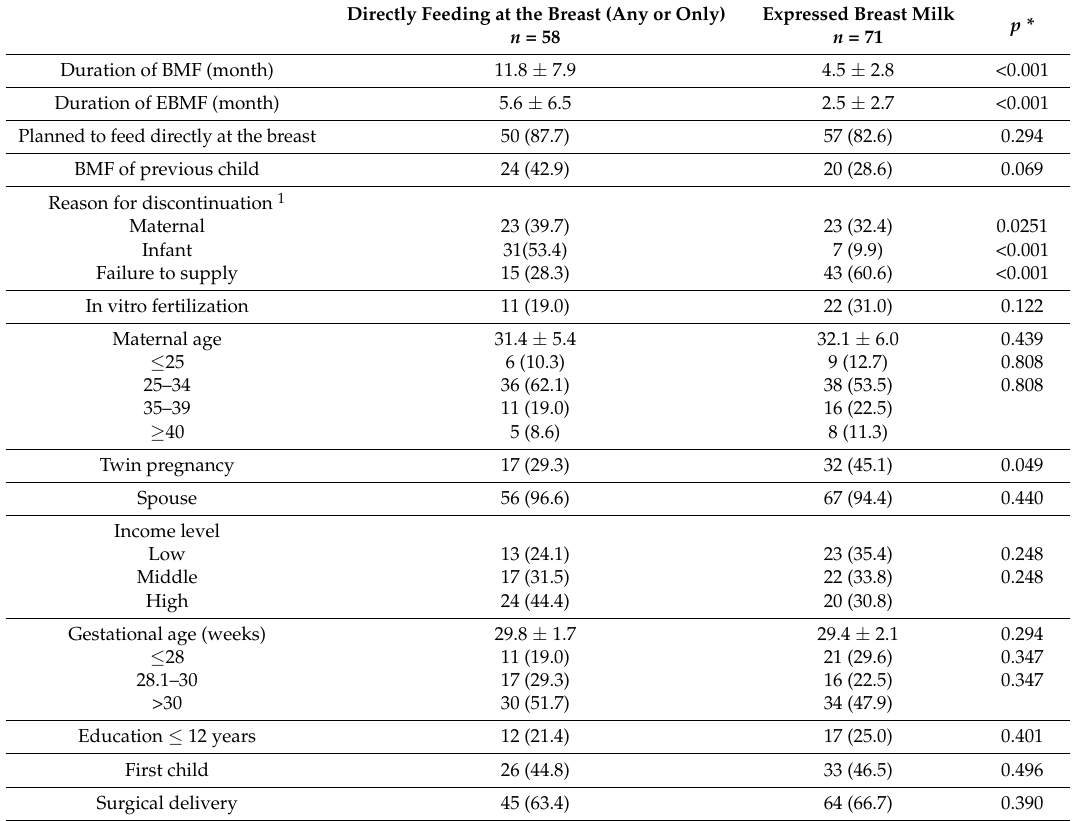
Table 4. Comparison between mothers who fed directly at the breast (any or only) vs. those who exclusively expressed breast